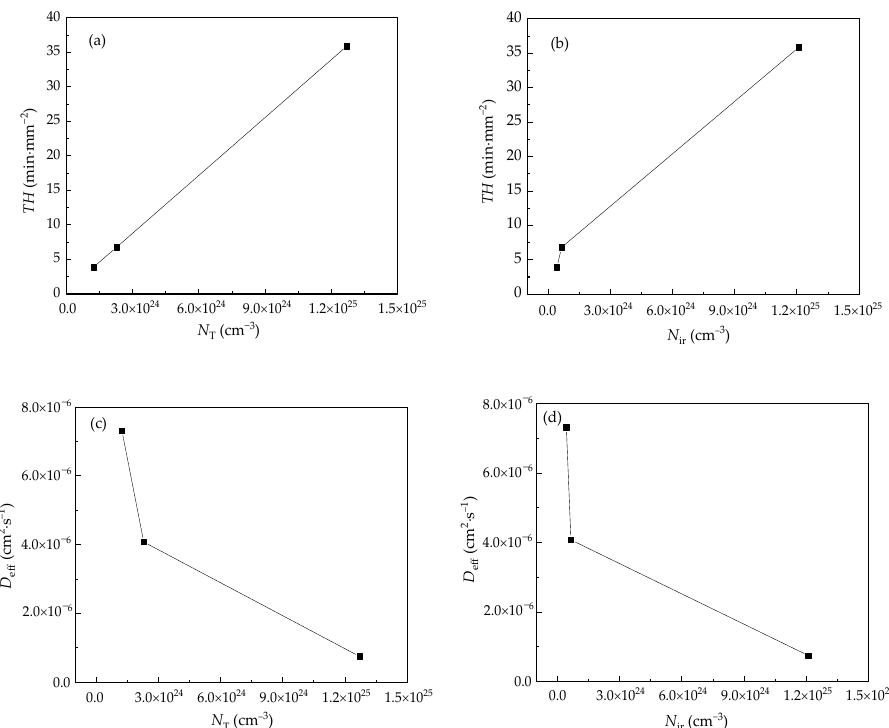
Figure 6. Relationship between TH , D eff , and N T , N ir : ( a ) TH – N T curve; ( b ) TH – N ir curve; ( c ) D eff – N T curve; ( d ) D eff – N ir curve.